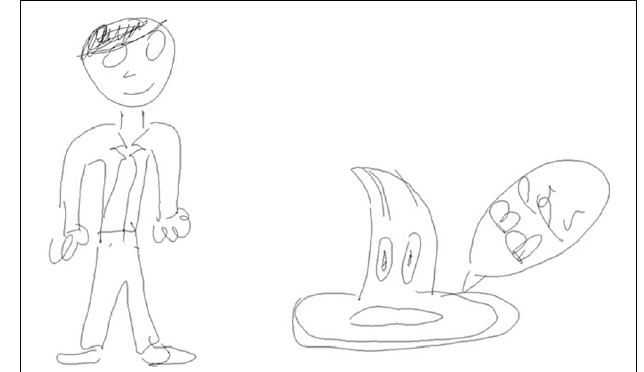
FIGURE 3 | Example of size modifications on elements and orientation modification in finger drawing on tablet at 3rd grade: compared to the unoriginal drawing (on the left), the size of the ears and hairs have been modified, and eyes orientation changed in the original drawing (on the right).